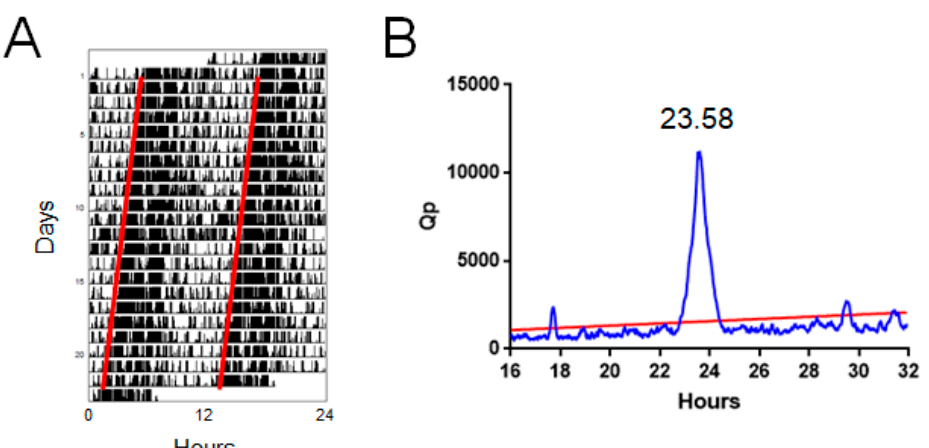
Figure 1. Standard measures of circadian activity. ( A ) Double-plotted actogram showing activity of a wildtype C57BL/6 mouse in constant darkness. The period of activity is slightly below 24 h, resulting in a small daily advance in activity onset (indicated by red lines). ( B ) Chi-square periodogram derived from A, showing a dominant period of 23.58 h. Sample data from Brown et al., 2016 [16] measured using PIR sensors.